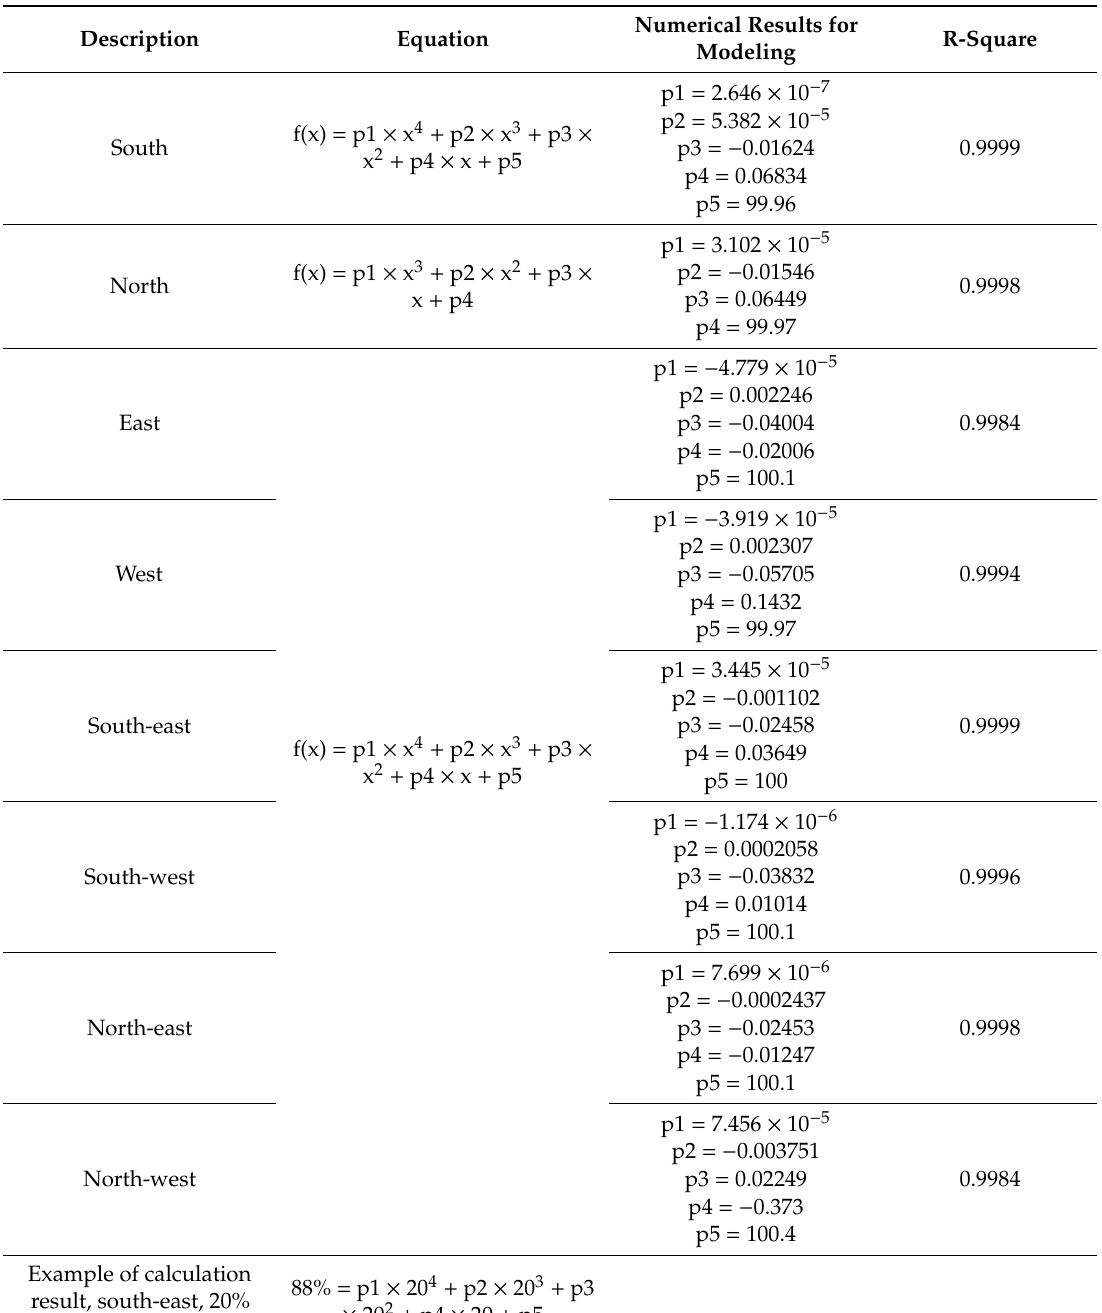
Table 8. The e ff ect of directional changes on a-Si performance (x = change in orientation ( ◦ ); f(x) = percentage value of the performance compared to the